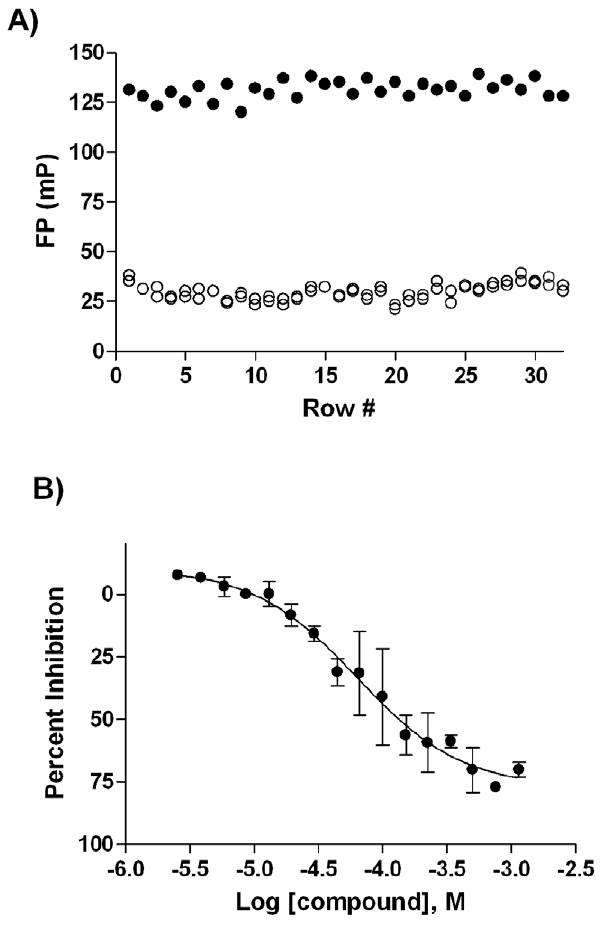
Figure 2. AGP Assay Miniaturization to 1536-well Format. A) N whole-plate scatter plot obtained from 4 m M AGP/1 m M Dipyridamole N ) and 1 m M Dipyridamole ( # ); B) concentration-response profile mix ( ). of Propranolol (